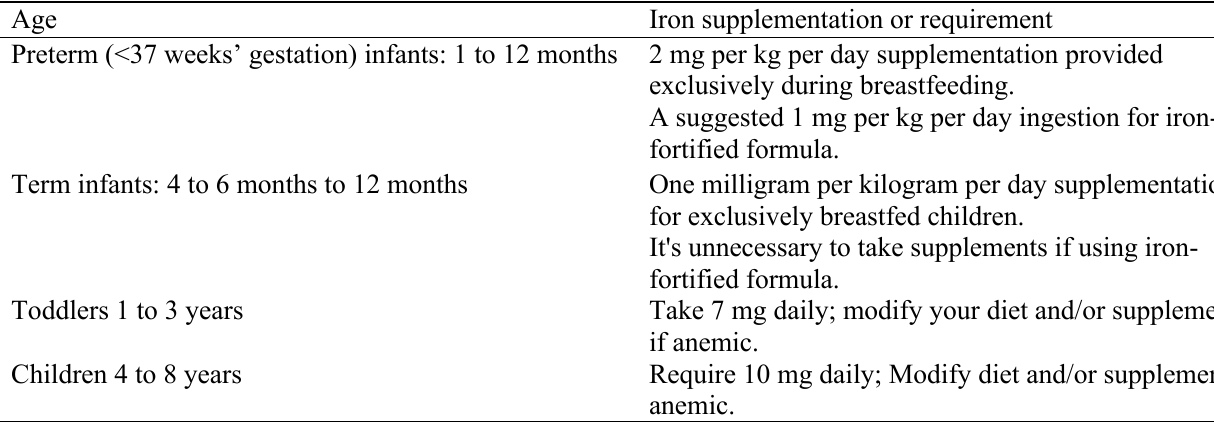
Table 1 . Elemental iron supplementation or requirement in children 20 Age